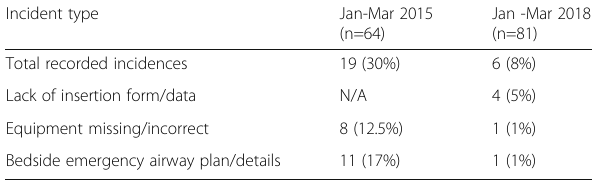
Table 1 (abstract 000515). See text for